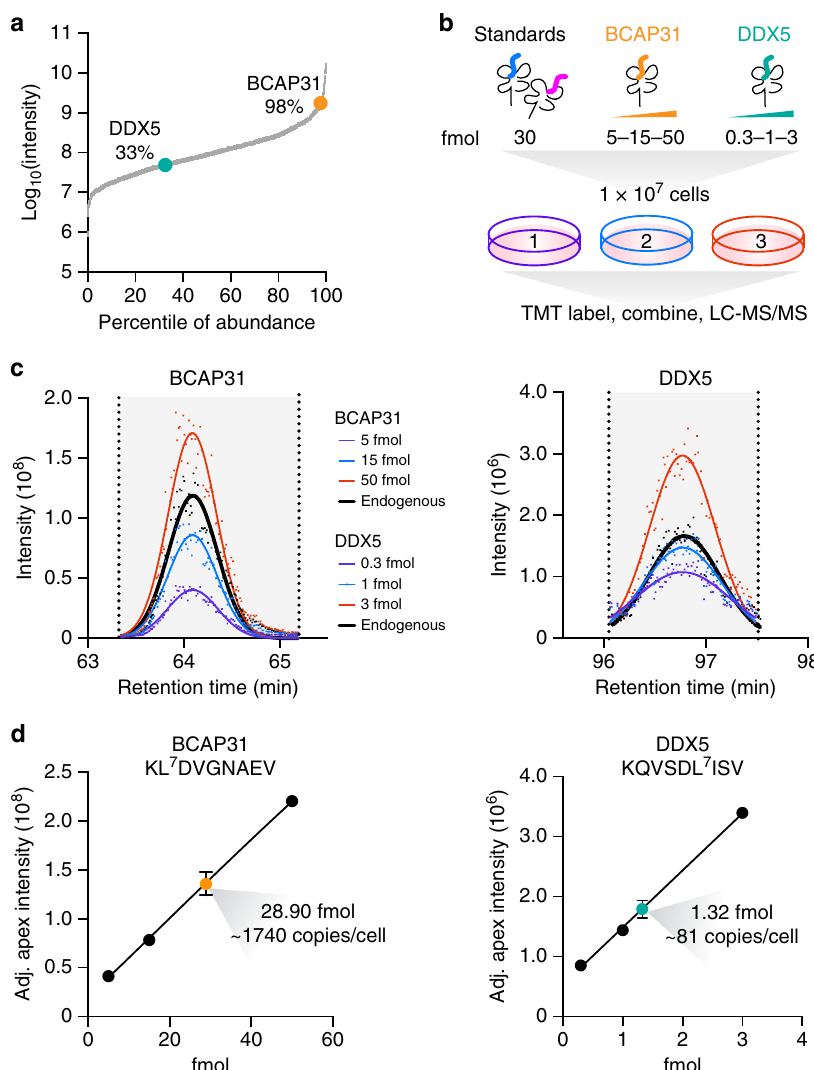
Fig. 3 Absolute quanti fi cation of pMHCs with hipMHC standards and isobaric labeling. a Peptide intensities for TMT-labeled MDA-MB-231 cells from Fig. 2 were determined by AUC quanti fi cation. Percentile of abundance represents a peptide ’ s rank relative to the most abundant peptide. b Experimental design. Normalization standards along with 5, 15, and 50 fmol of BCAP31 and 0.3, 1, and 3 fmol of DDX5 hipMHCs were added to three biological replicates of 1 × 10 7 MDA-MB-231 cells, and peptides from MHC complexes were isolated, labeled, and analyzed via LC-MS/MS. c Chromatographic elution pro fi les for the three TMT reporter ion intensities of the hipMHC standard curve (colored), along with the average ( n = 3) TMT reporter ion intensity trace of the endogenous peptide (black). Each MS2 scan is represented as a single point, and elution pro fi les are fi tted with a gaussian distribution (line). d Adjusted (hipMHC normalized) apex intensity versus fmol of hipMHC added creates a standard curve from which the endogenous concentration of antigen is calculated. For both linear fi ts of BCAP31 and DDX5, r 2 > 0.999. The endogenous peptide is presented as the mean value ± SD for n = 3 biological replicates. Source data are provided in the Source data fi uniform across peptides and that peptide-speci fi c internal standards may be required for absolute quanti fi cation of each pMHC of interest.